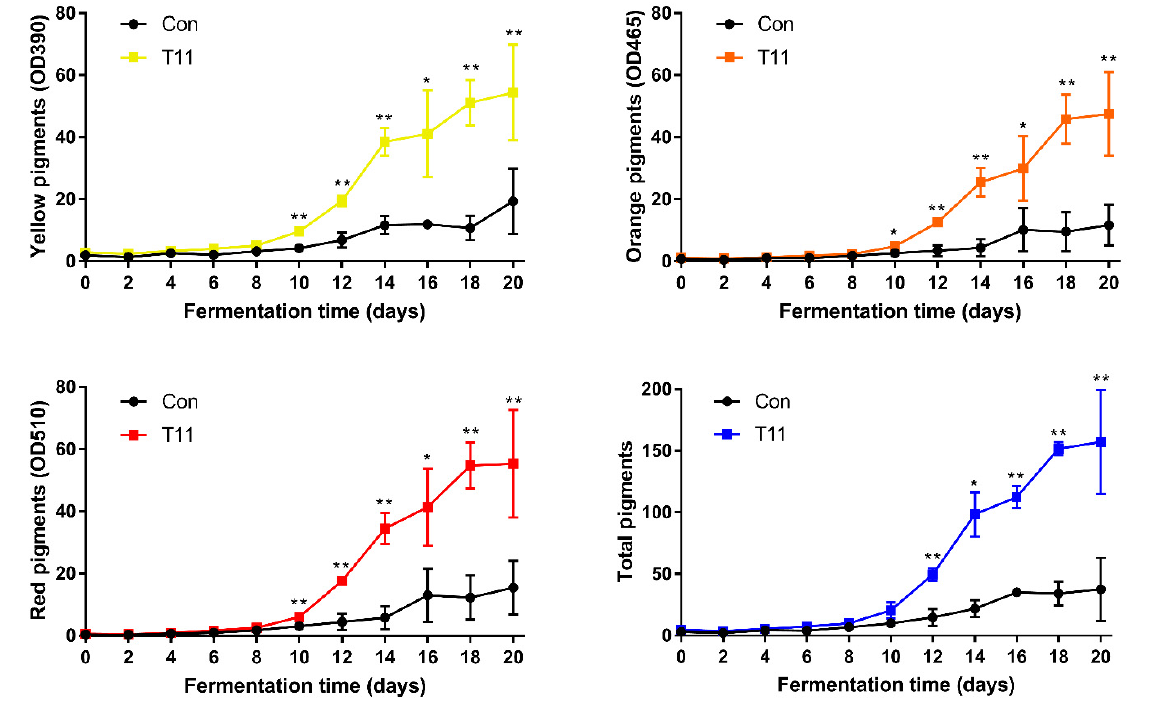
Figure 4. Effect of fermentation time on MPs production under optimal supplemental concentration of T11 (pu-erh tea extracted with 15% ethanol). Note: * p < 0.05 and ** p < 0.01 versus the Con group.